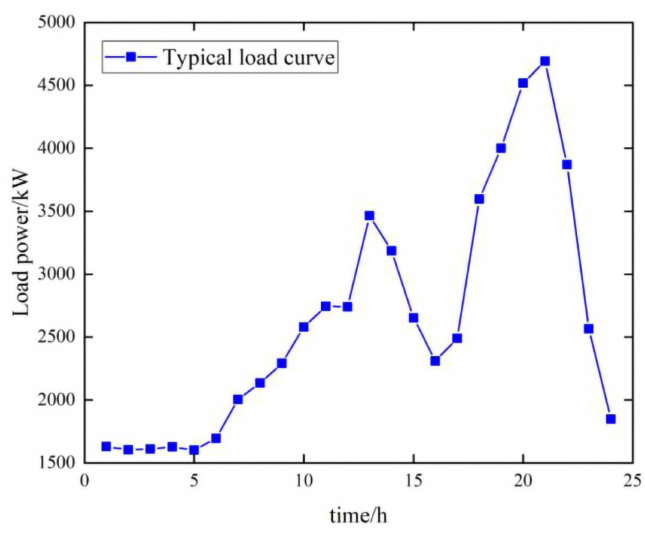
Figure 8. Photovoltaic typical sunrise force curve.